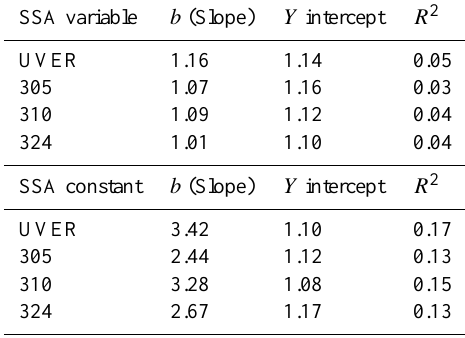
Table 1. Results of linear regression analysis between OMI/Brewer ratio of UV products and AAOD at 340nm for the two approaches: SSA variable and SSA constant. The parameters are the following: the slope of the regression ( b ), the Y intercept, and the correlation coefficient ( R 2 )